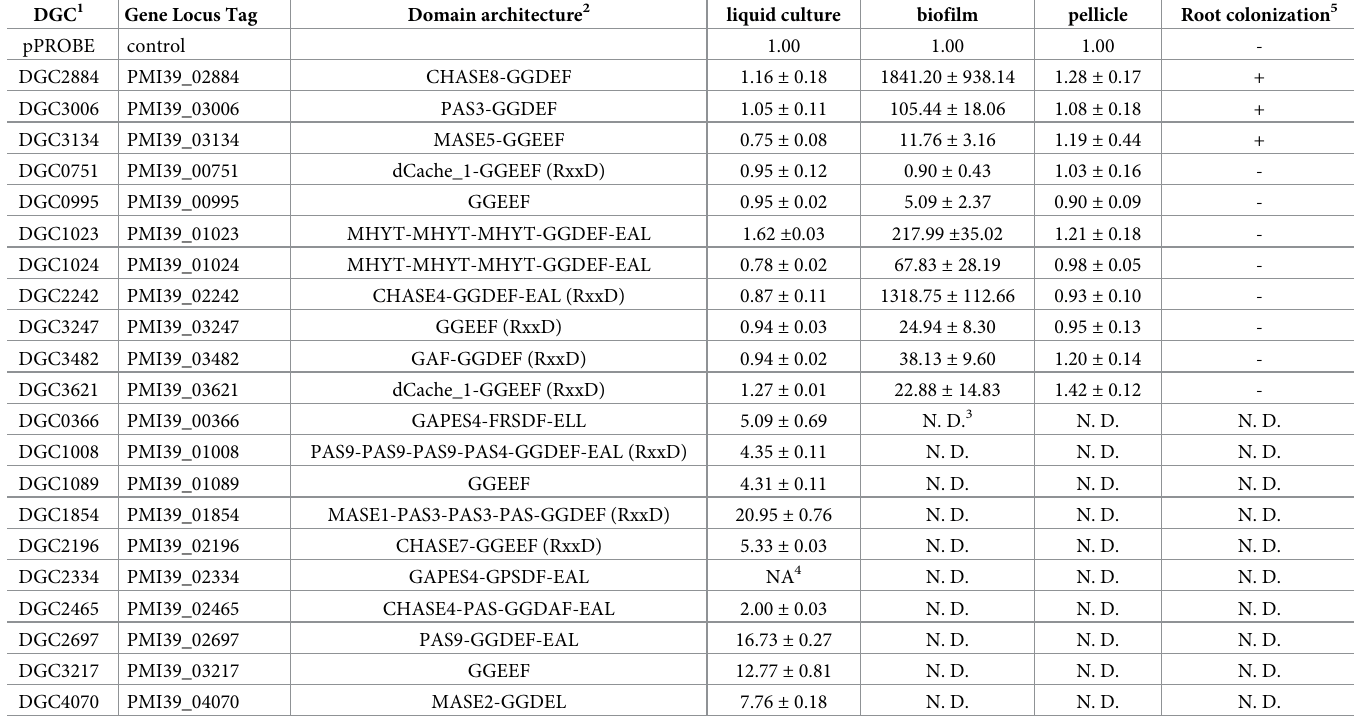
Table 1. Promoter activity under various growth